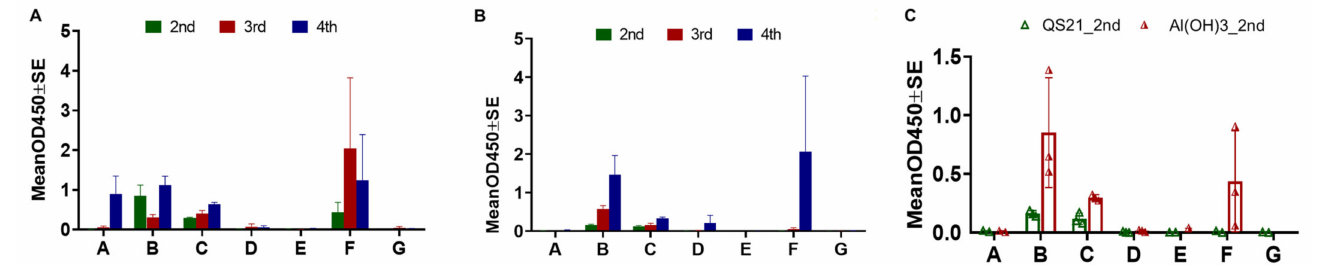
Figure 1. Antibody response post-vaccination tested by ELISA. Test subjects (mice) were divided into 2 groups (n = 3 per group): one group received the peptide mixture 1 (mainly S1) with QS21 as the adjuvant, and the other group received the peptide mixture 1 with Al(OH) 3 as the adjuvant. There were a total of 6 inoculations at 2-week intervals and 5 time points where blood samples were collected. Plasma was analyzed by ELISA with peptide A1-G1-coated plates. In total, 3 time points were selected for comparison. ( A ) shows the results of the 3 mice that received the Al(OH) 3 adjuvant, ( B ) the results of the three mice with QS21 as adjuvant, and ( C ) is the comparison of blood post 2nd vaccination. There are significant antibodies in both adjuvant groups against peptides B ( p = 0.0058 < 0.01) and F ( p = 0.0009 < 0.01) ( C ). No antibodies were induced against peptides A, D, E, or G after 2 vaccinations.